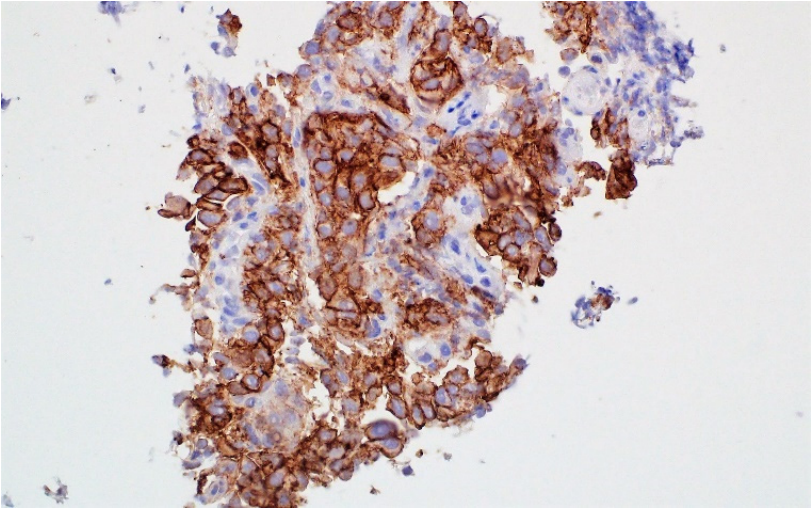
Figure 1. Immunohistochemistry analysis of PD-L1 expression on tumour cells using 22C3 anti-PD-L1 antibody (DAKO) (PD-L1 TPS—90%).